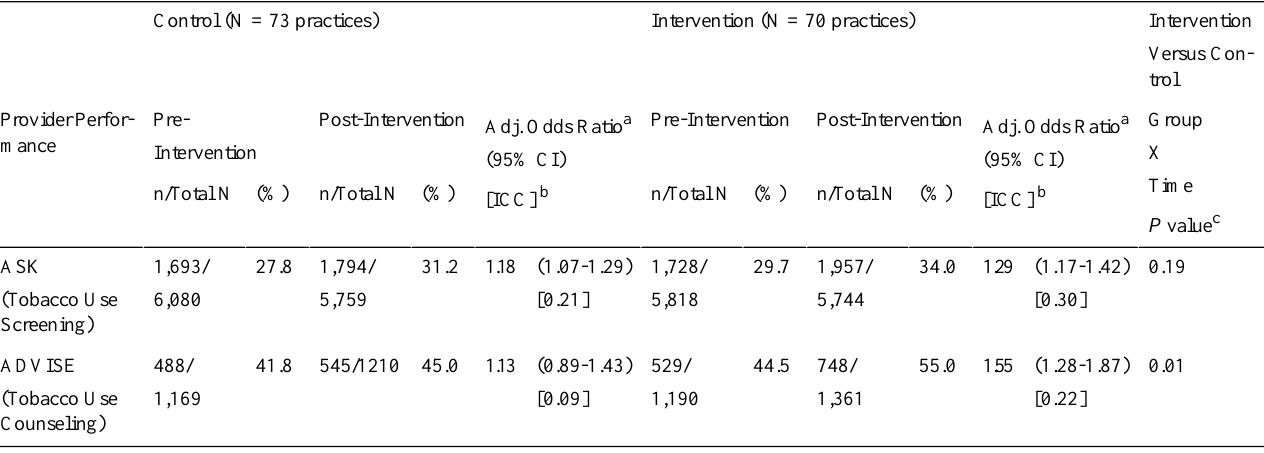
Table 2. Odds of receiving screening and advice to quit smoking among patients in 143 intervention and control practices, comparing pre- and